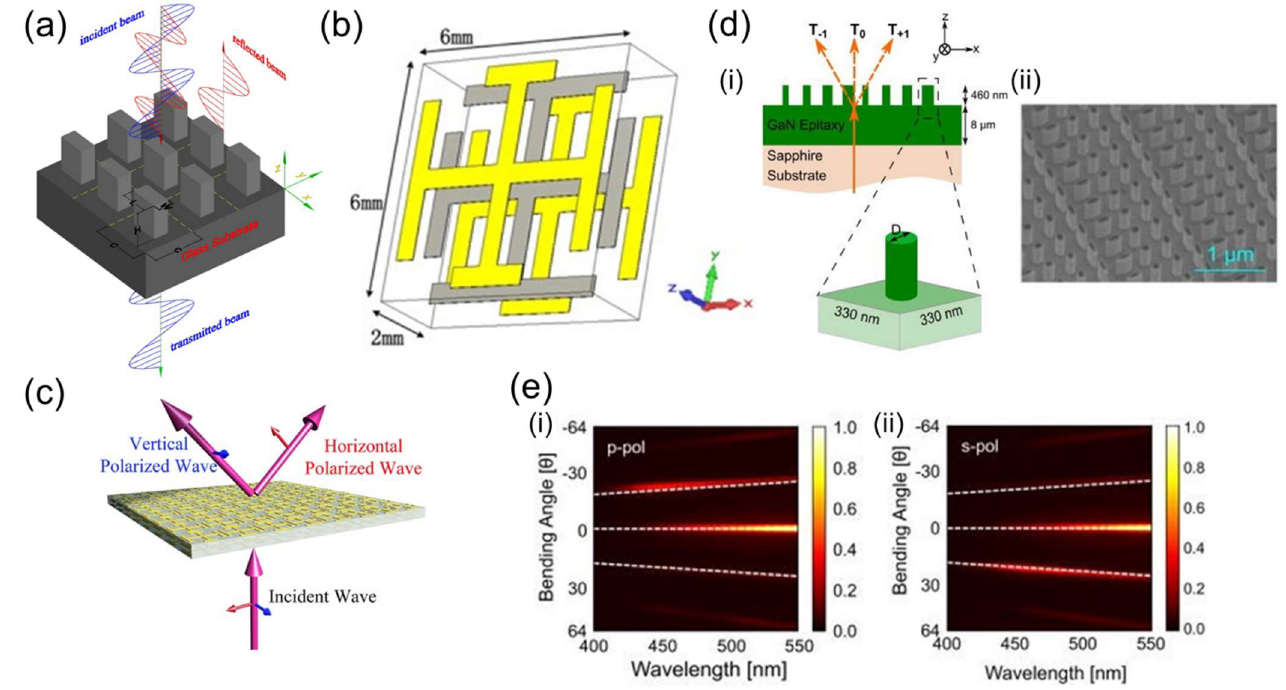
Figure 4. ( a ) Schematic diagram of a beam splitter based on an array of silicon nanobricks located on a glass substrate. Incident beams with polarization along the long axis of the nanobrick are reflected, while incident beams with polarization along the short axis are transmitted [61]. ( b ) Schematic diagram of the structure of a typical unit of a Huygens metasurface [62]. Copyright 2015 John Wiley and Sons. ( c ) Schematic illustration of the beam−splitting capability of the Huygens metasurface [62]. Copyright 2015 John Wiley and Sons. ( d ) ( i ) Schematic diagram of the GaN circular nanopillar metasurface. ( ii ) SEM image of the fabricated GaN sample. Reprinted from [63], with the permission of AIP Publishing. ( e ) Spectrally resolved back focal plane image showing the transmitted light intensity in various diffraction orders for p − ( i ) and s −polarization ( ii ), respectively. Reprinted from [63], with the permission of AIP Publishing.